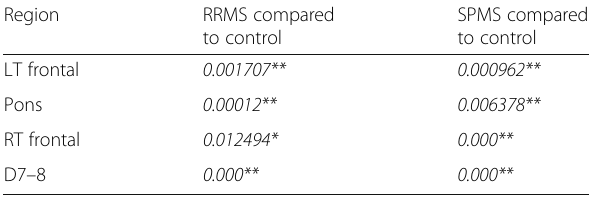
Table 2 P value of ADC increase per region